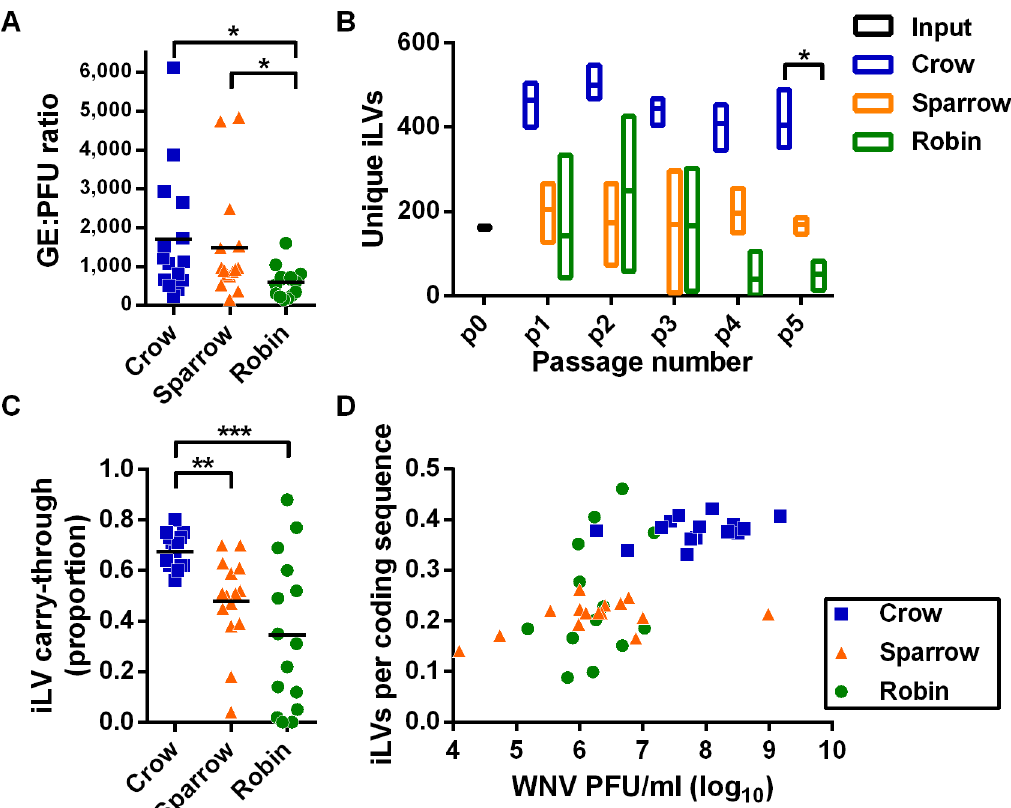
Fig 3. Intrahost virus population density contributes to the accumulation of deleterious mutations. ( A ) WNV genome equivalent to plaque-forming unit (GE:PFU) ratio from all bird passages (n = 15 per species; * , P < 0.05, Kruskal-Wallis test with Dunn ’ s correction). ( B ) Unique intrahost length variants (iLVs, i.e. single nucleotide insertions and deletions, mean ± range) from the WNV coding sequence ( * , crow p5 vs robin p5, P = 0.0219, Kruskal-Wallis test with Dunn ’ s correction) and ( C ) proportion of unique iLVs detected in the subsequent replicate series passages (e.g. carry-through from p1a to p2a) calculated after each passage ( ** , P = 0.0084; *** , P = 0.0005, Kruskal-Wallis test with Dunn ’ s correction). ( D ) Correlation of virus population sizes (PFU/ml) to the number of iLVs per coding sequence from each individual (Pearson r = 0.6150, P < 0.001).